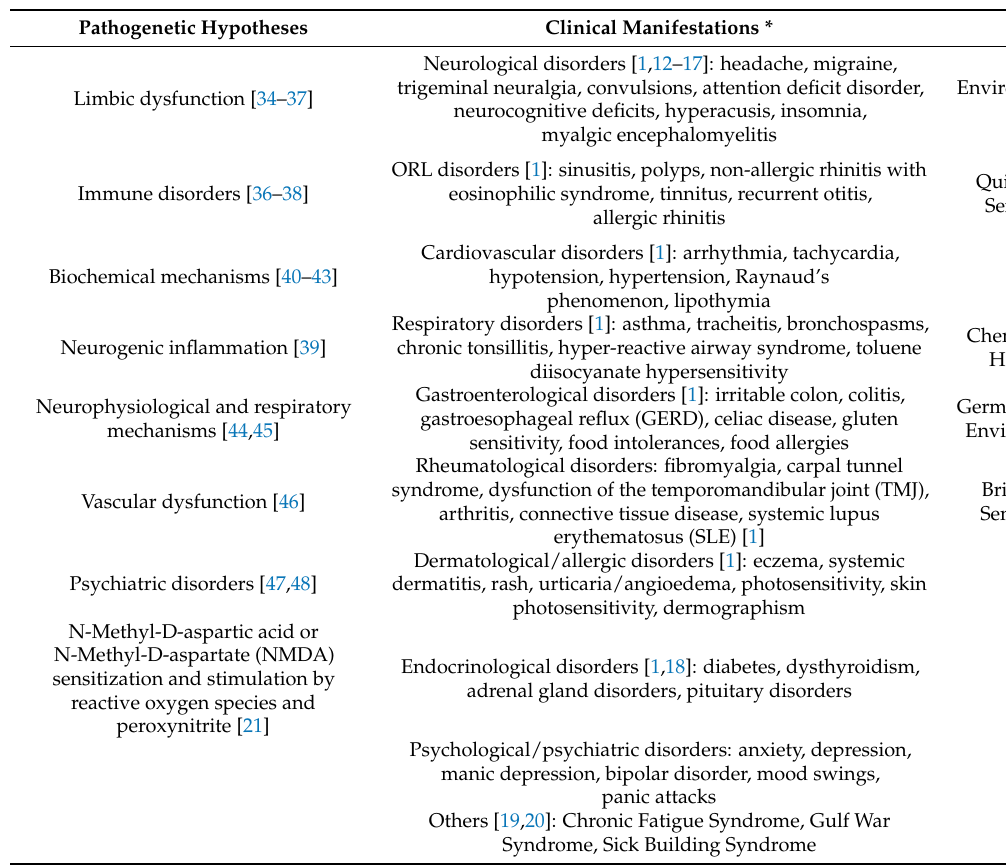
Table 1. Clinical and pathogenetic overview of MCS